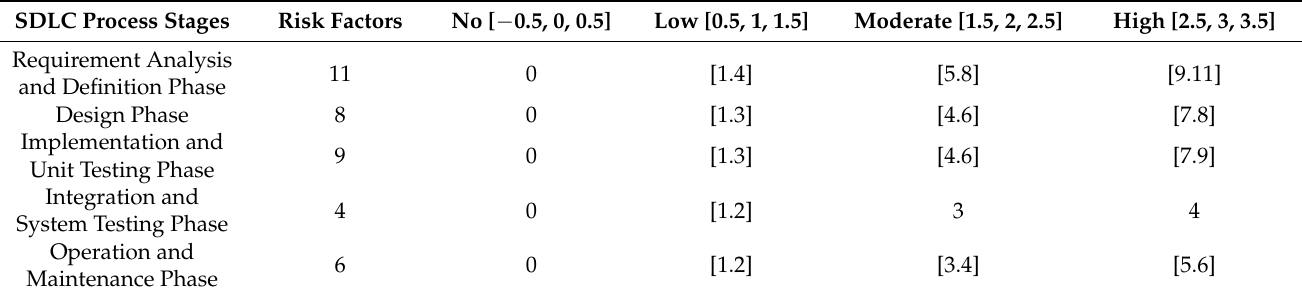
Table 7. Description of Fuzzy and Crisp intervals of ANFIS security risk assessment